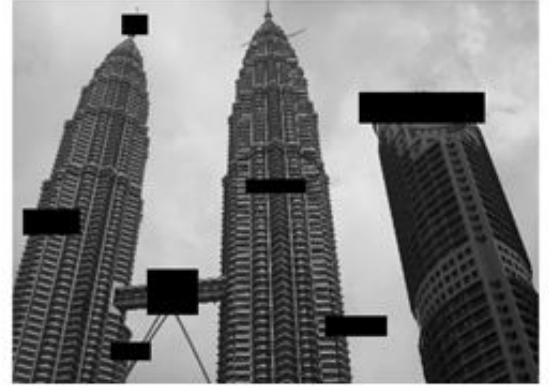
Fig. 5. Test image of KLCC-tower containing damaged blocks of different sizes.